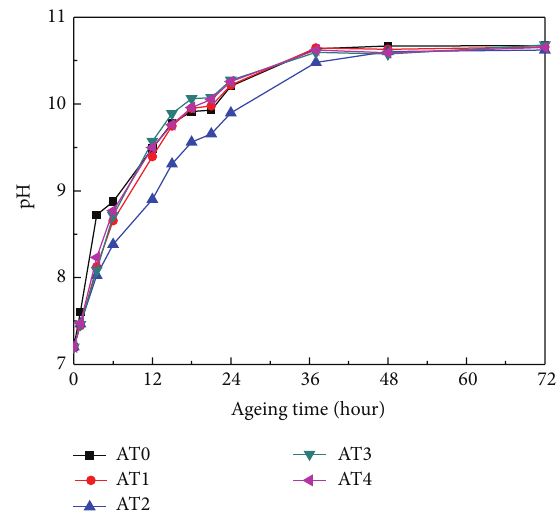
Figure 6: pH value as a function of immersion time.